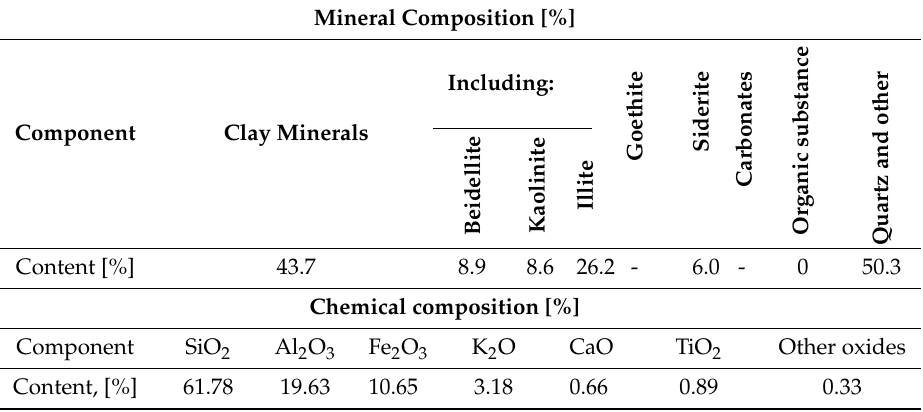
Table 2. Mineral and chemical composition of loam used in the